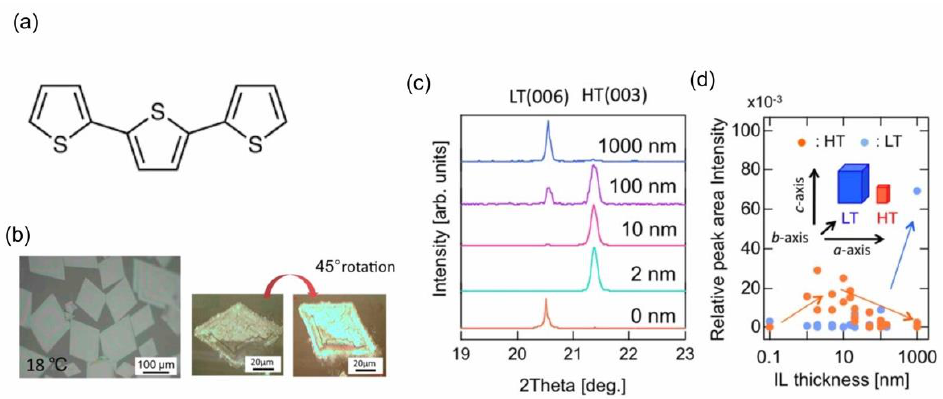
Figure 11. ( a ) Molecular structure of 3T. ( b ) Optical microscope image of an IL-VLS grown 3T crystals using an IL [emim][TFSA], along with a set of polarized optical microscope images of one piece of the crystals before and after a 45 degree-sample rotation. ( c ) XRD patterns of 3T samples IL-VLS grown for different thick IL films. ( d ) Plots of the relative peak area intensities of the LT 006 and HT 003 reflections, which are both normalized by the peak area intensity of α -Al 2 O 3 0006 reflection, as a function of the IL thickness. Reproduced with permission from ref. [60]. Copyright 2019, IOP Publishing Ltd.